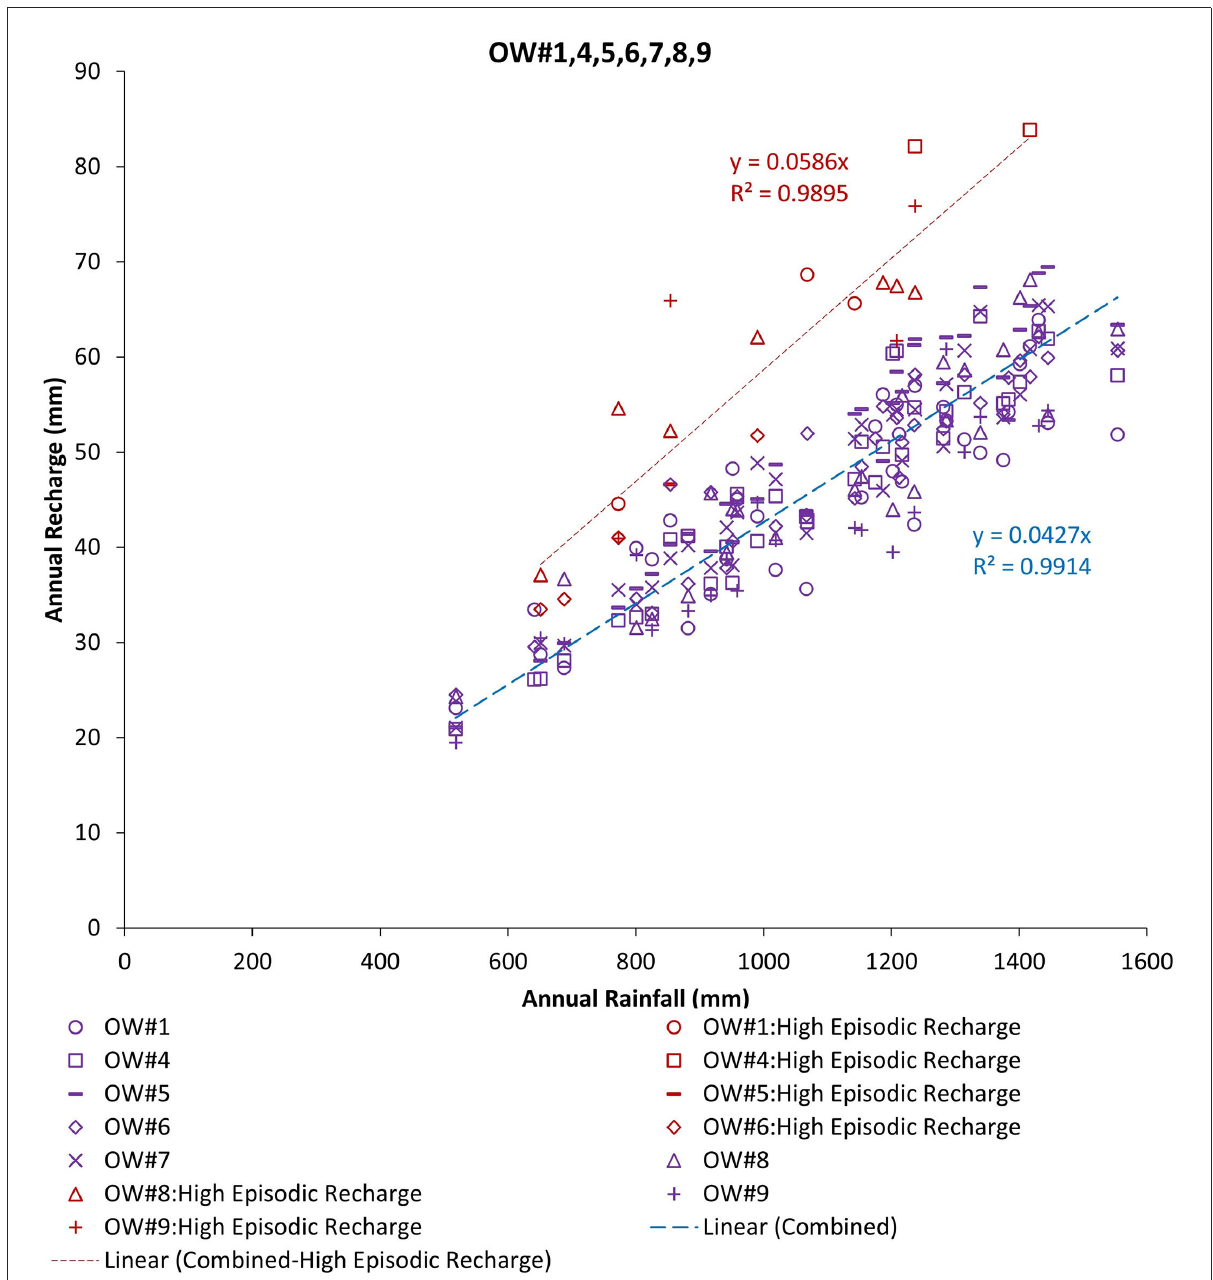
FIGURE4 Annual recharge vs. annual rainfall variation in Gundlupet taluk for OW#1, 4, 5, 6, 7, 8, and